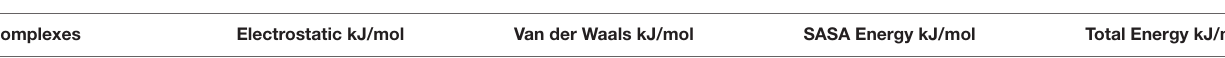
TABLE 2 | MM-PBSA binding free energy calculation for the formed